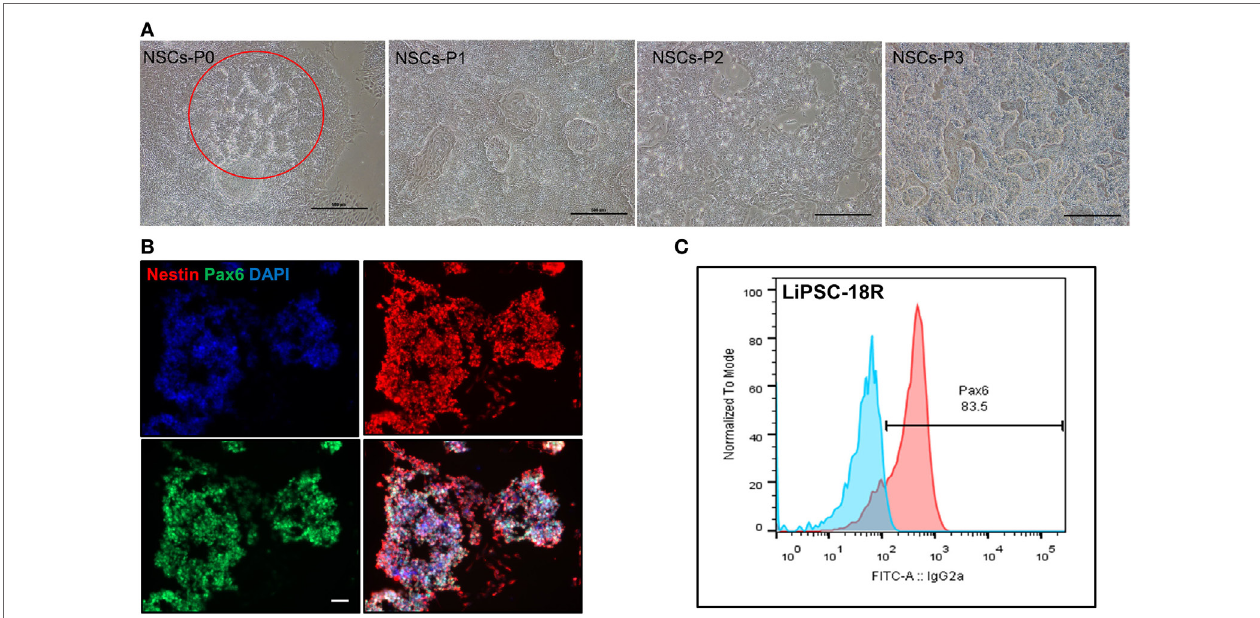
FigUre 4 | Differentiation of LiPSCs into neural stem cells (NSCs). (a) Morphology of LiPSC 18R-derived cells was changing during the differentiation from P0 to P3. Red circle shows the neural rosette-like structure at the end of P0. (B) Immunofluorescent staining of NSCs at the end of P3 revealed that they express NSC-specific markers (Nestin and Pax6). (c) Flow-cytometry analysis at the end of P3 demonstrated that around 83.5% of cells acquired NSC morphology. Scale bar: 100